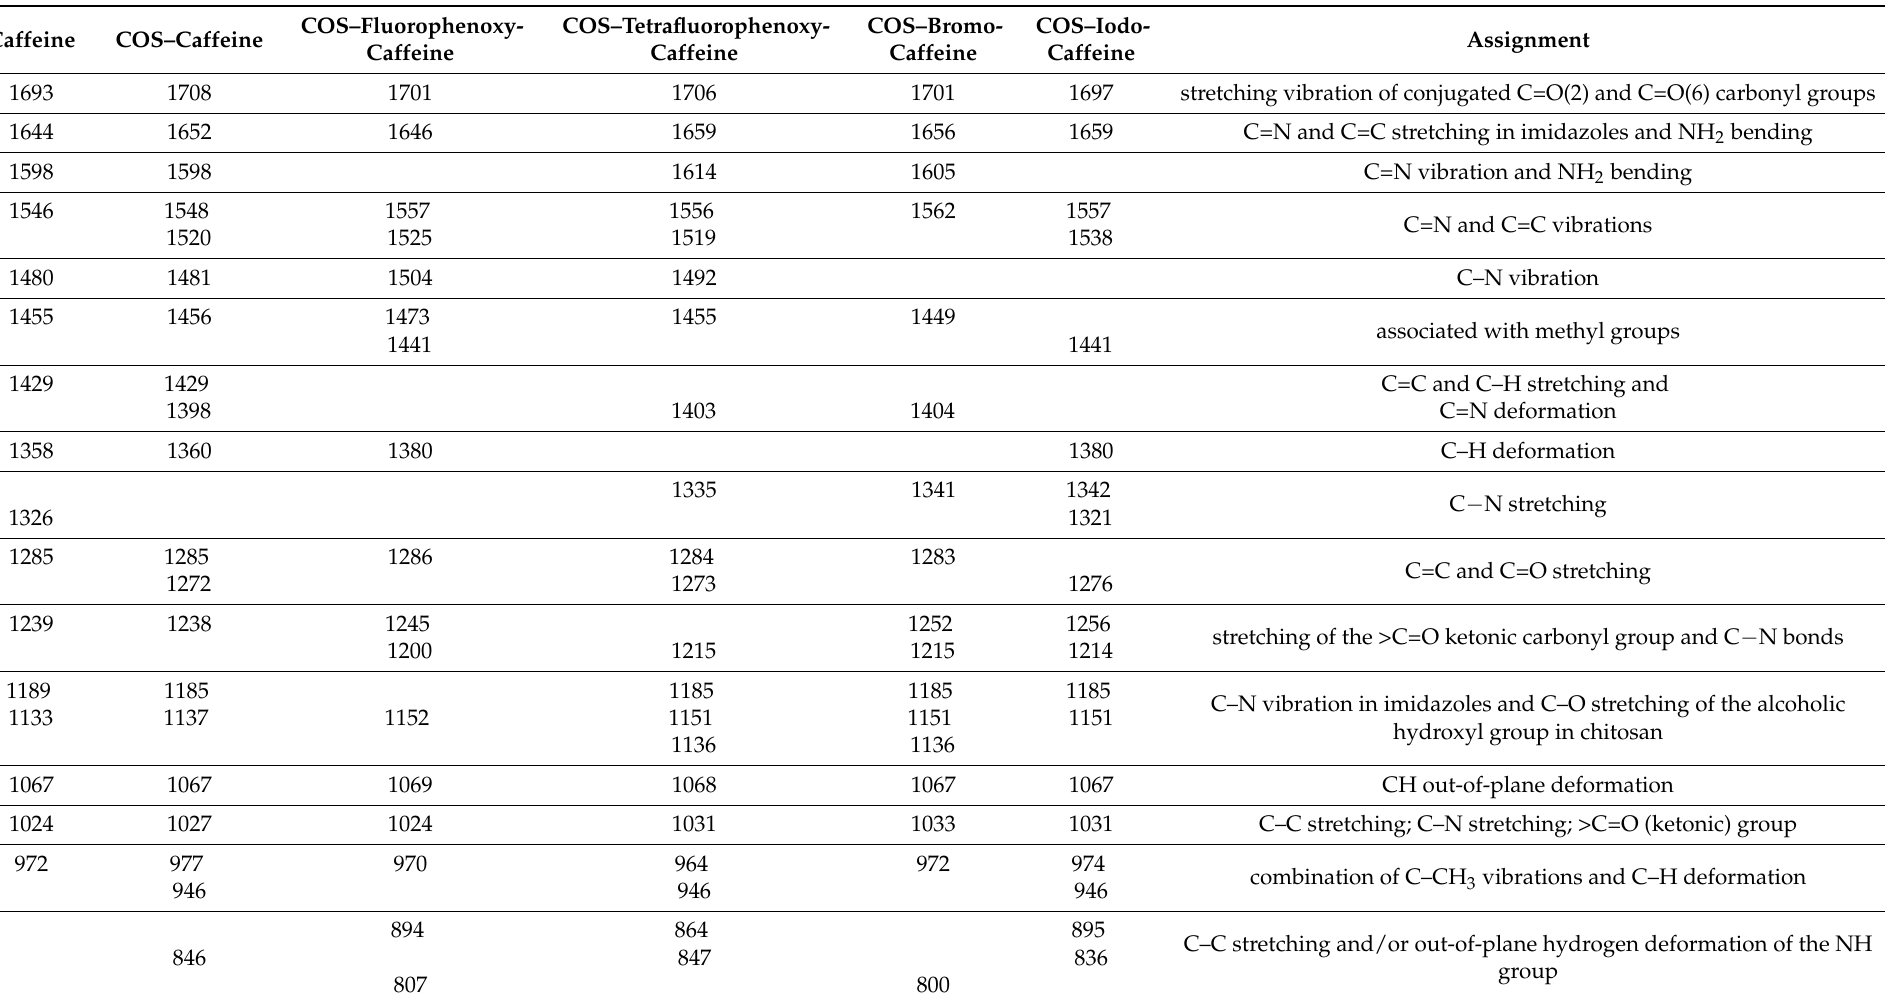
Table 1. Absorption bands of caffeine, its conjugate with chitosan oligomers (COS), and the conjugates of its derivatives (fluorophenoxy-caffeine,